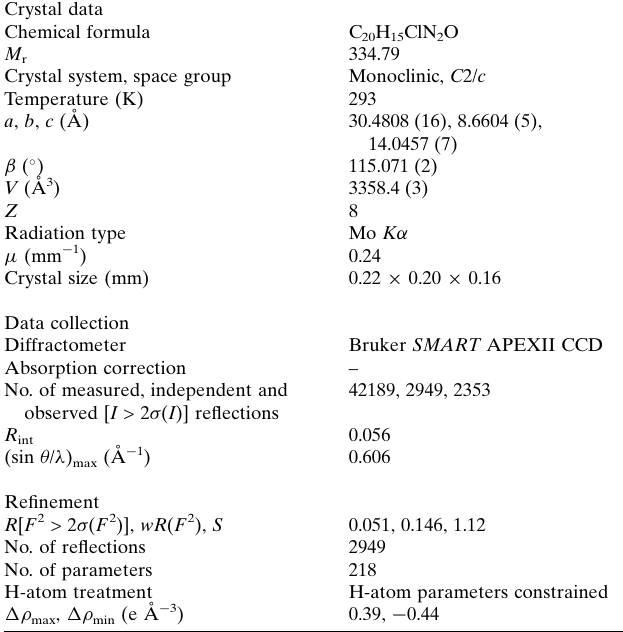
Table 2 Experimental details. Crystal data Chemical